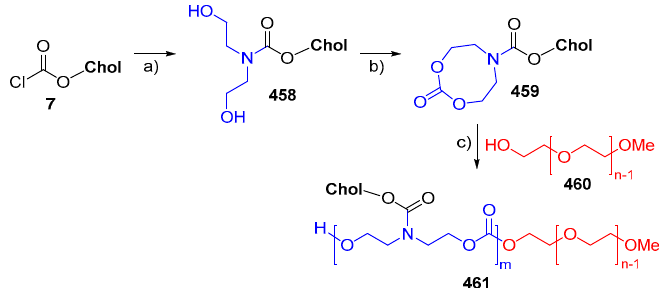
Scheme 107. Synthesis of PEGylated amphiphilic diblock copolymers. Reagents and conditions: a ) diethanolamine, Na 2 CO 3 , THF/H 2 O (2:1), 0 °C to rt, 16 h; b ) ethyl chloroformate, Et 3 N, THF, 0 °C to rt,